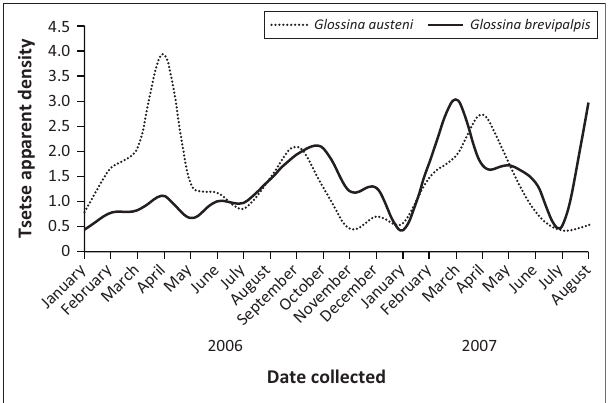
FIGURE 1: Monthly apparent density for Glossina austeni and Glossina brevipalpis at Boomerang Farm from January 2006 to August